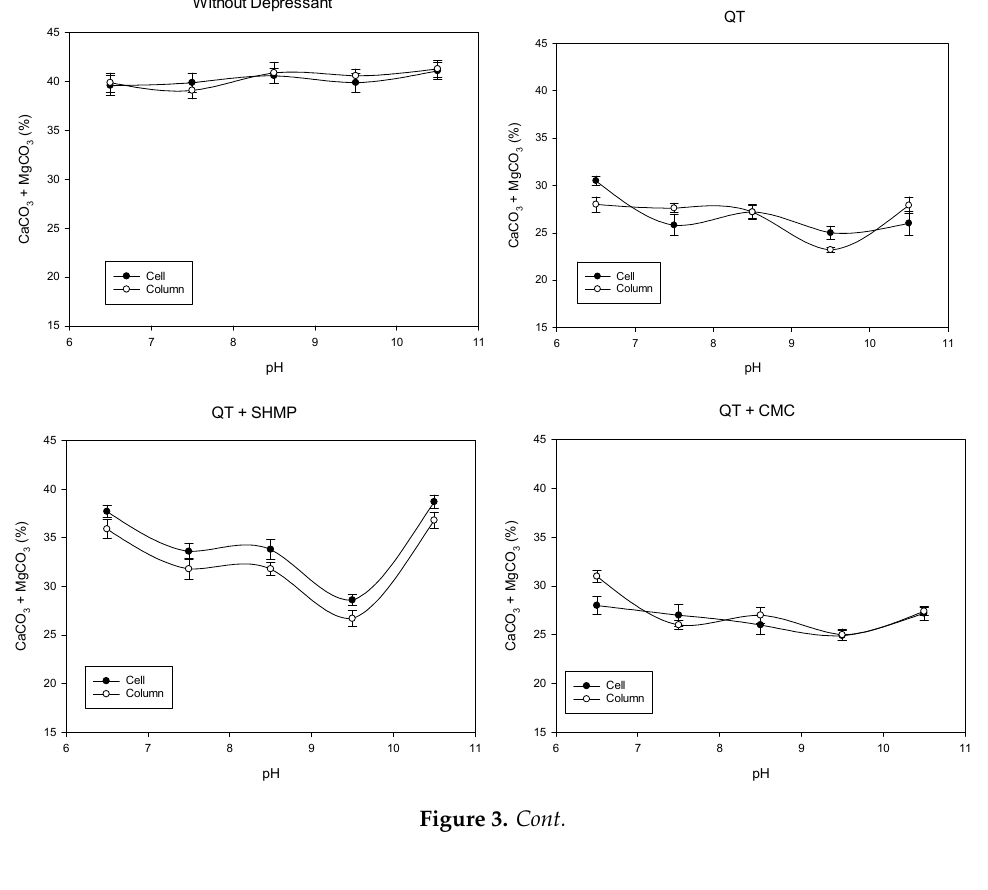
Figure 2. Metallurgical recovery for cell and column as pH function and type of depressant.